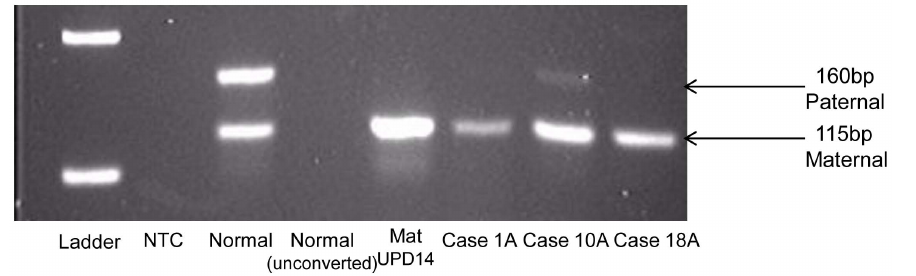
Figure 3. Loss of Paternal 14q32 Allele in Cluster A. Agarose gel for cases in Cluster A showing loss of the paternal allele. Lane 1: Molecular marker, 2: NTC-no template control, 3: Normal sample, 4: Normal sample unconverted, 5: positive maternal UPD14, Lanes 6–8: adult mutant